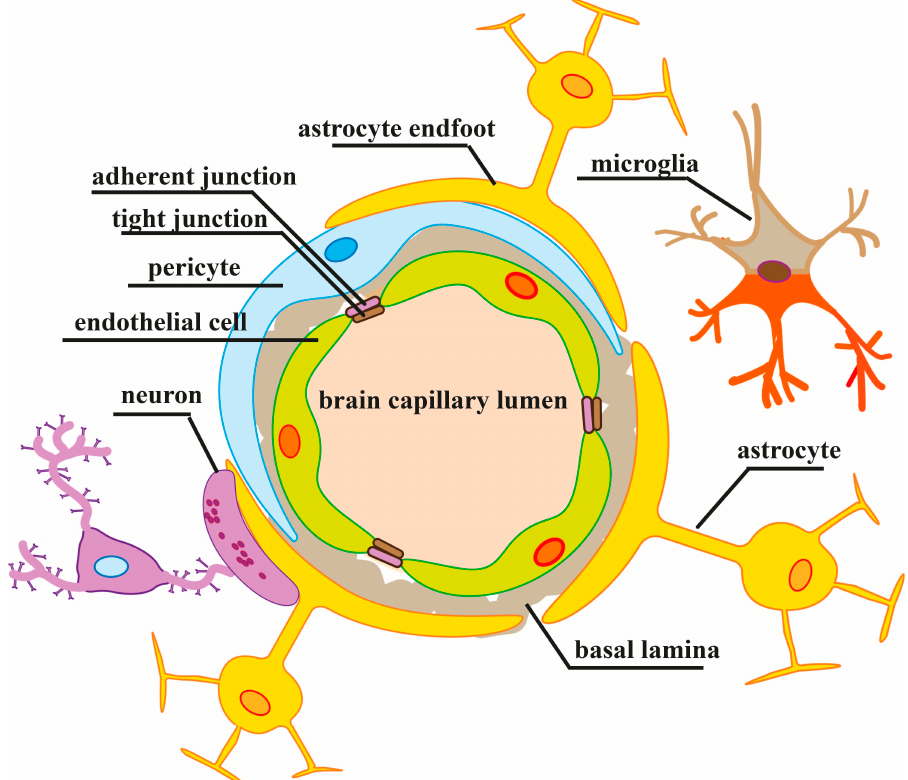
Figure 1. Organization of the neurovascular unit. The NVU is composed of endothelial cells, astrocytes and pericytes. The cerebral endothelial cells form the BBB providing low paracellular permeability via a set of tight and adherent junctions which connect adjacent endothelial cells. Pericytes partially surround the endothelium and, along with the endothelial cells, are enclosed in the basal lamina, a structure that provides mechanical support and functions as a barrier as well. Astrocyte endfeet are in close contact with endothelial cells and pericytes. The perivascular network of astrocytes connects the blood vessel with neurons. The NVU components in cooperation with perivascular microglia intimately interact with each other via anatomical relationships and reciprocal chemical signaling mediating brain function in normal and pathological conditions.